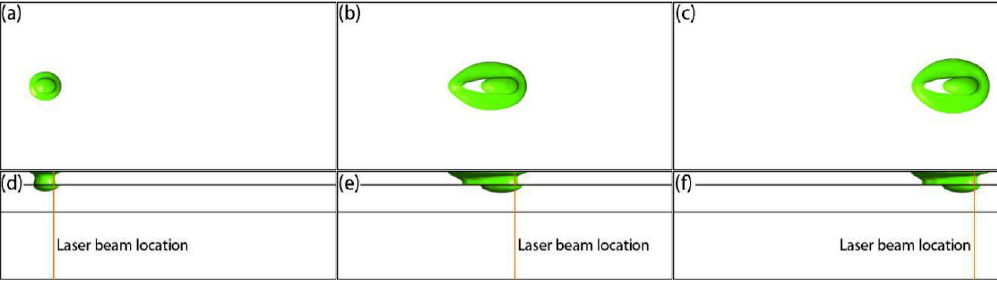
Figure 6. Simulation results of top- ( a – c ) and side- ( d – f ) view molten pool shapes at different times: ( a , d ) 6 × 10 −5 s; ( b , e ) 4.5 × 10 −4 s; ( c , f ) 8.4 × 10 −4 s.